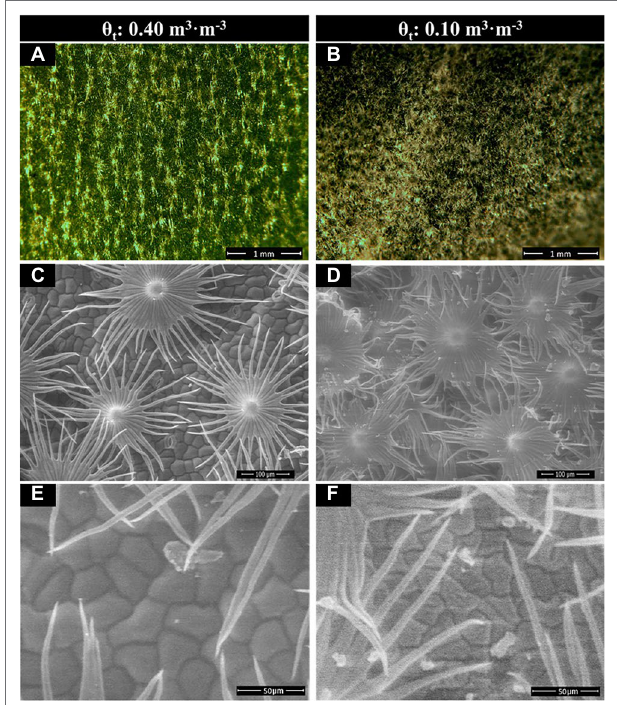
FIGURE 4 | Dissected compound microscopy image of the leaf upper (adaxial) surface (A,B) and scanning electron microscopy (SEM) image of leaf trichomes (C,D) and epidermal cells (E,F) of Shepherdia ×utahensis plants at the substrate volumetric water content treatments ( θ t ) of 0.40 and 0.10 m 3 ·m − 3